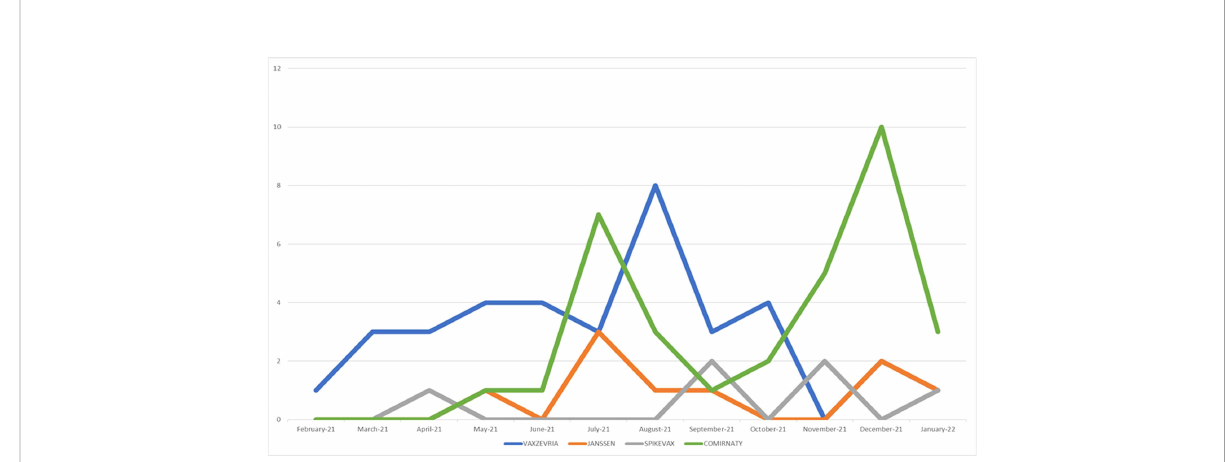
FIGURE 1 Trends of spontaneous reporting of CLS from EudraVigilnce database between January 1 st , 2021 and January 14 th ,